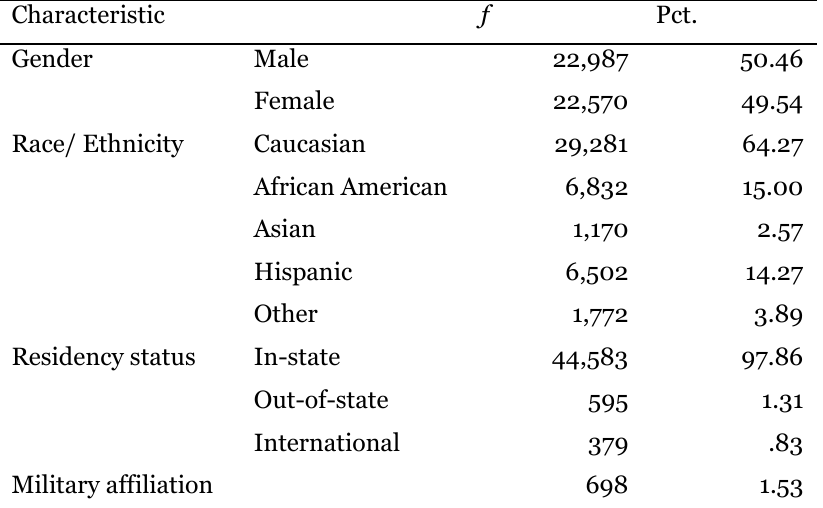
Table 1 Sample Demographics (n=45,557)